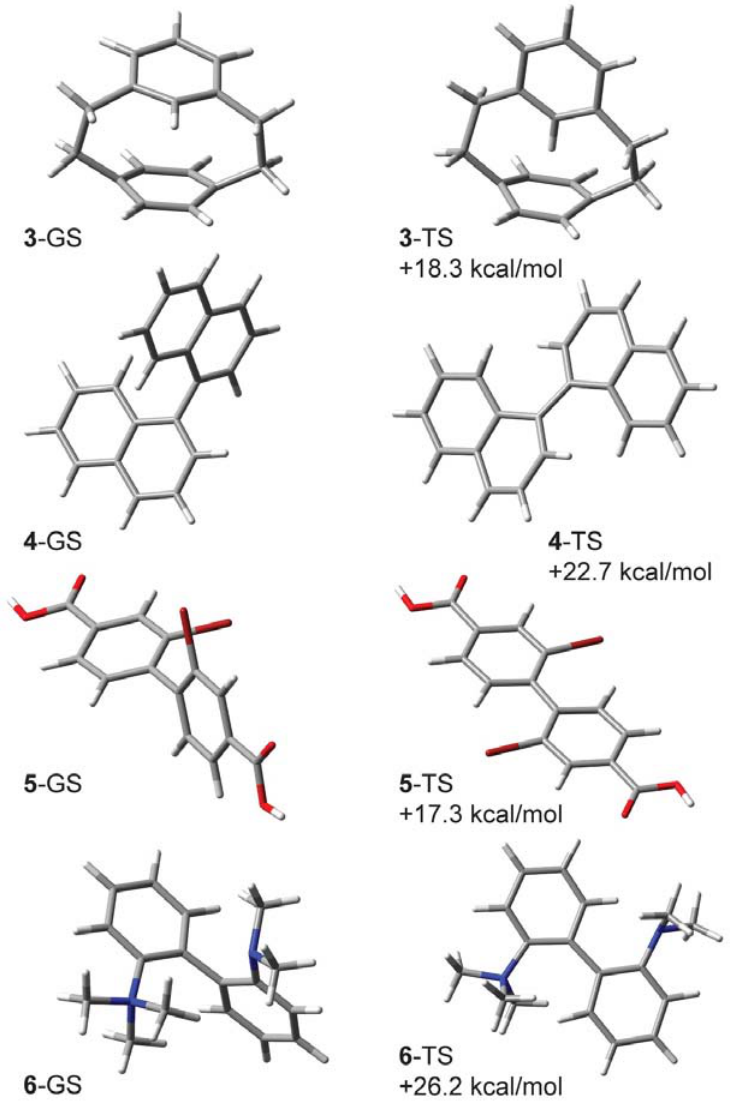
Figure 3. B3LYP/6-31G(d,p) lowest-energy ground state (GS) structures and transition structures (TS) and their computed enthalpies of activation (  H ‡ ) for compounds 3 – 6 .